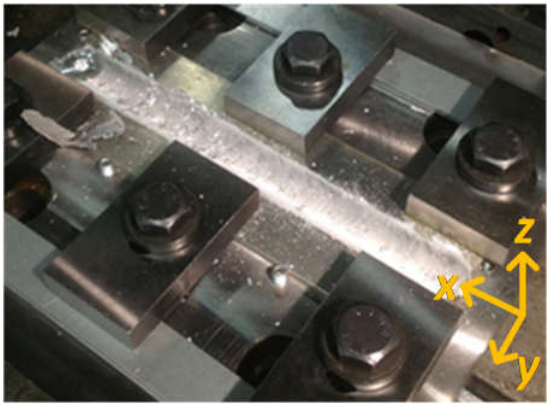
Figure 2. Photo of the welding setup including the clamping system and a finalized welding scar from the 20 mm rotating tool.